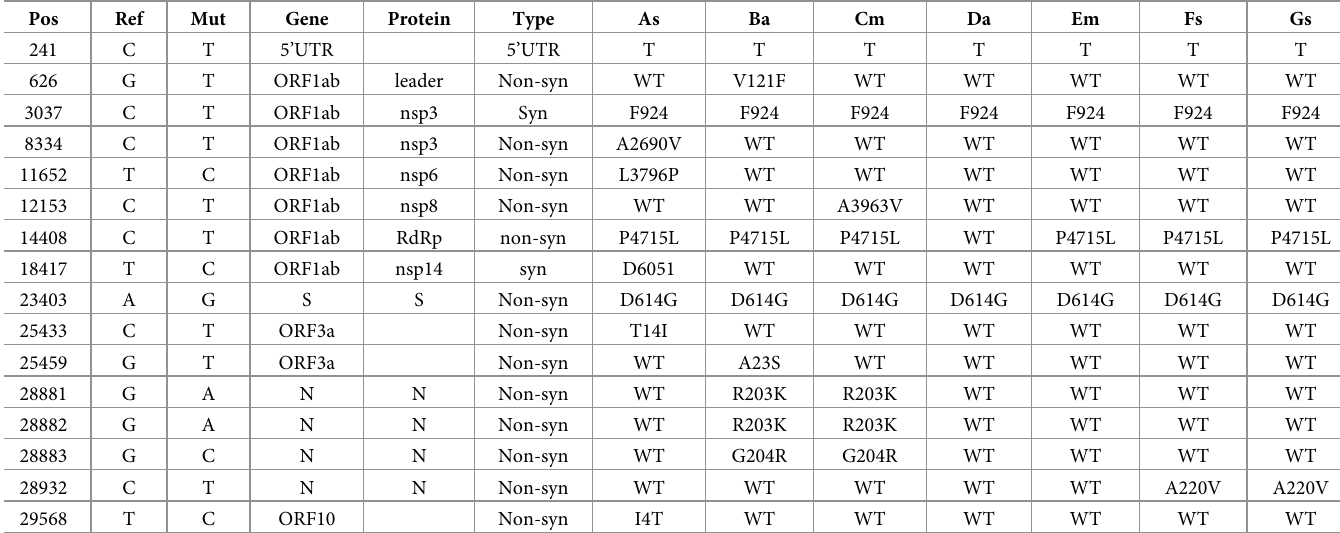
Table 3. Summary of the mutations retrieved in each extract by whole genome analysis.